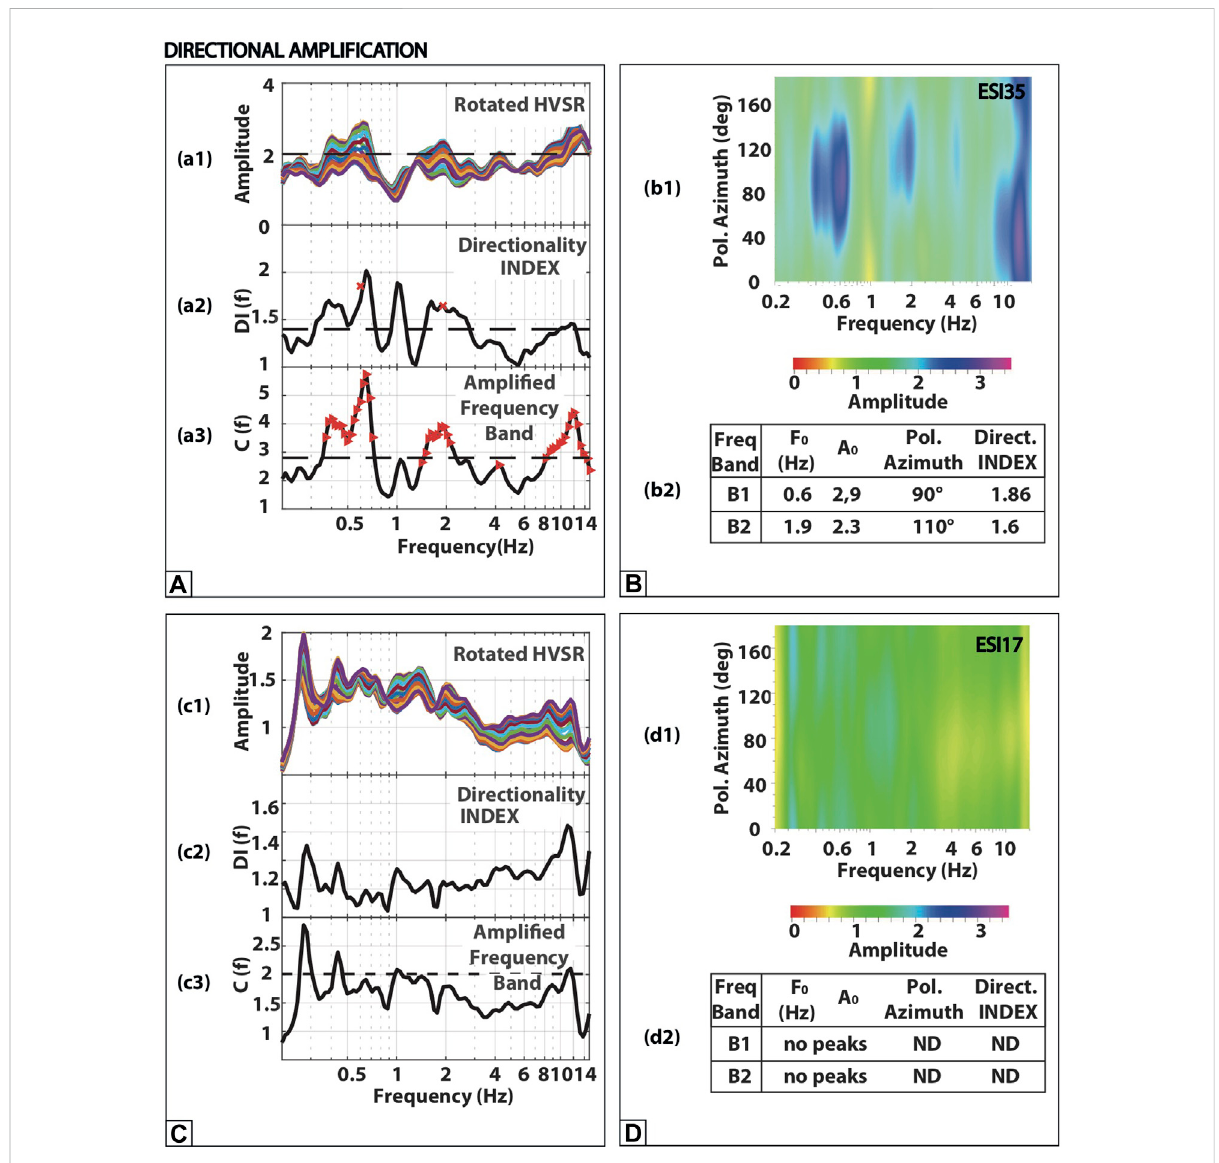
FIGURE 2 Results at two exempli fi cative stations for directional ampli fi cation estimated through the HVSR by rotating the two horizontal components at steps of 10 ° from 0 ° to 180 ° : ESI35 (clear peaks), panels (A,B) , and ESI17 (no peaks), panels (C,D) . HVSR curves obtained separately for each rotation angle are graphed in panels a1 and c1. Rotated HVSRs are also plotted using a contour plot: the x-scale representing frequency; the y-scale, the rotation angle; and the color scale is related to amplitude levels (panels b1 and d1). In this way, HVSRs show to what extent horizontal motion is ampli fi ed, compared to vertical motion, as a function of frequency and direction of motion allowing the detection of the frequency band, where ground motion tends to be mostly horizontal. We apply an automatic criterion to interpret results and distinguish directional peaks (Pischiutta et al., 2018).Weusethedirectionalityindex(DI)(f)(Eq.1),de fi nedastheratiobetweenthemaximumandminimumamplitudevaluesgivenatthefrequency peak(F 0 )byall rotationangles (panelsa2andc2).Toassessthefrequencybandwhere thelargestampli fi cationfalls,weconsidertheparameter C(f), asde fi nedinEq.3(panelsa3andc3).Finally,thedirectionalampli fi cationpatternateachstationisde fi nedthroughthefrequencyband,F 0 ;maximum amplitude (A 0 ); polarization azimuth; and directionality index (DI). Such parameters obtained for the two exempli fi cative stations are summarized in panels b2 and